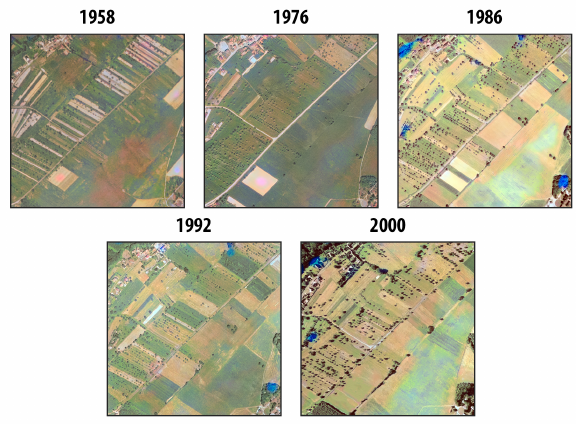
Figure 6. Average temporal profiles of GCC and EG for the sampled grasslands.